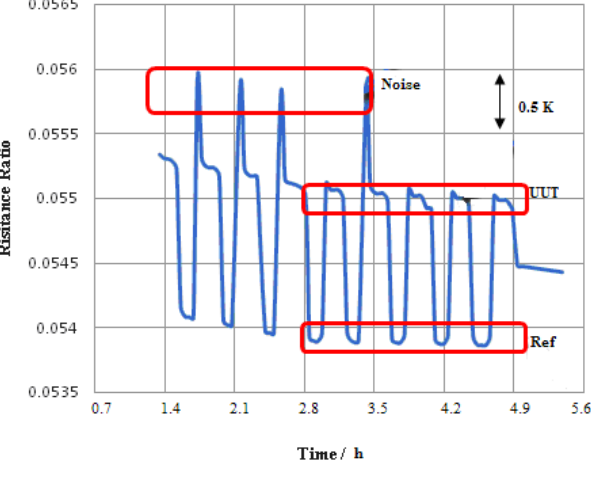
Fig. 3. Controlled temperature near the triple point of Ar.